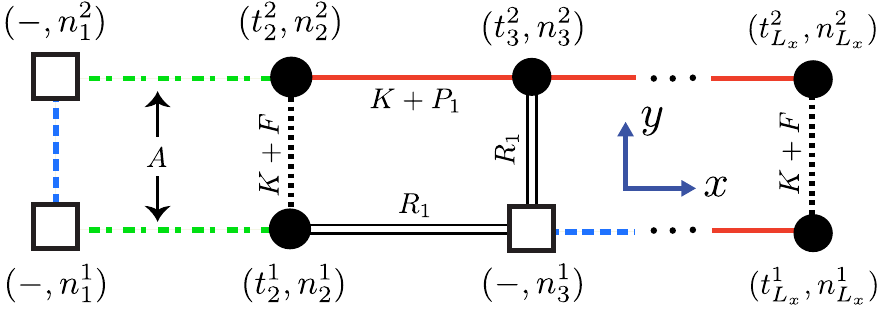
Proteins or solvent clusters may occupy lattice sites, where the front-view ( y - z plane) of an aggregate of A β (1-40) proteins is shown along with the interactions between = 2 nucleus is represented by dashed-dotted lines (free proteins and solvent clusters. The n c energy A denoting the nucleation). Dotted and solid lines illustrate interactions between sheet proteins. Double solid lines illustrate a protein-solvent interface. Dashed (blue) lines have no